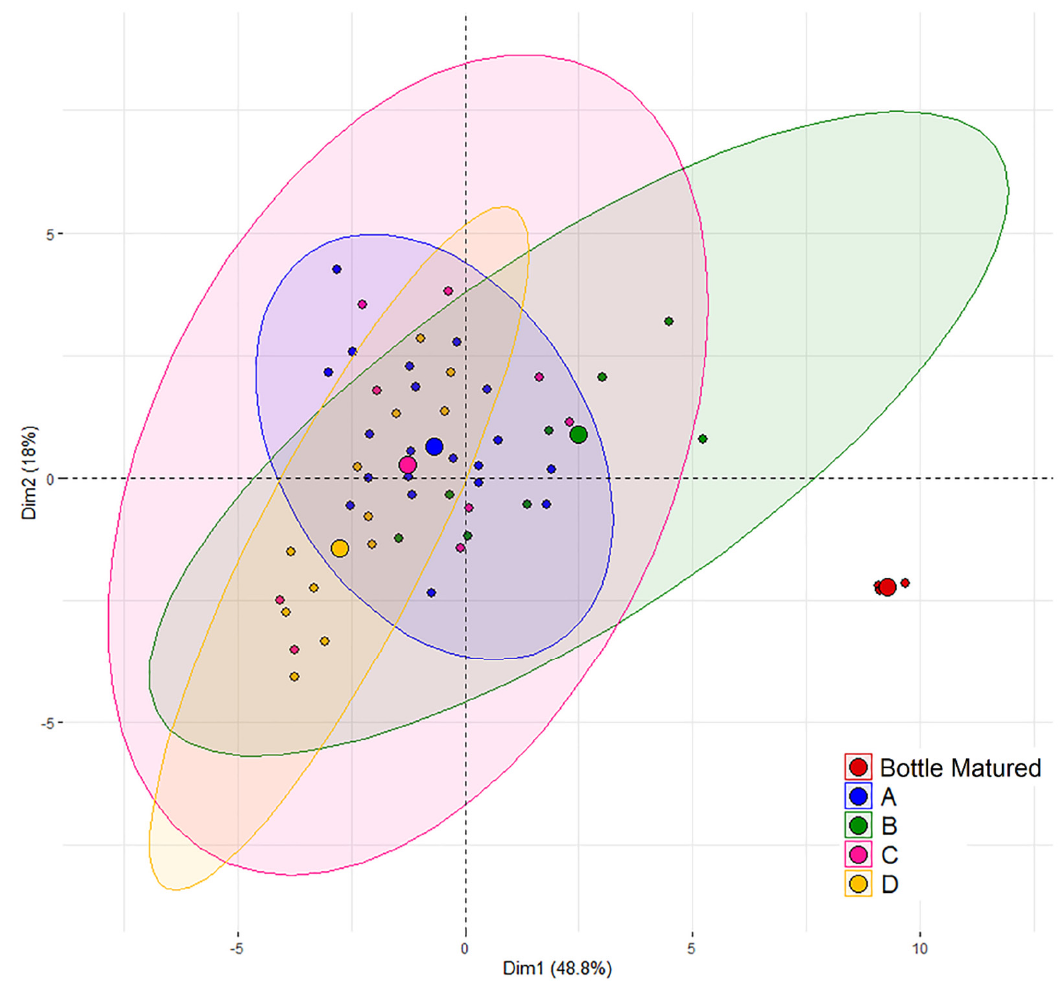
Figure 1. Principal Component Analysis performed on wines aged in oak barrels from the cooperages A, B, C, and D and bottle matured wine, in a total of 50 wines. The wines are represented in the plane of the two first components which express, respectively, 49% and 18% of the total variance.